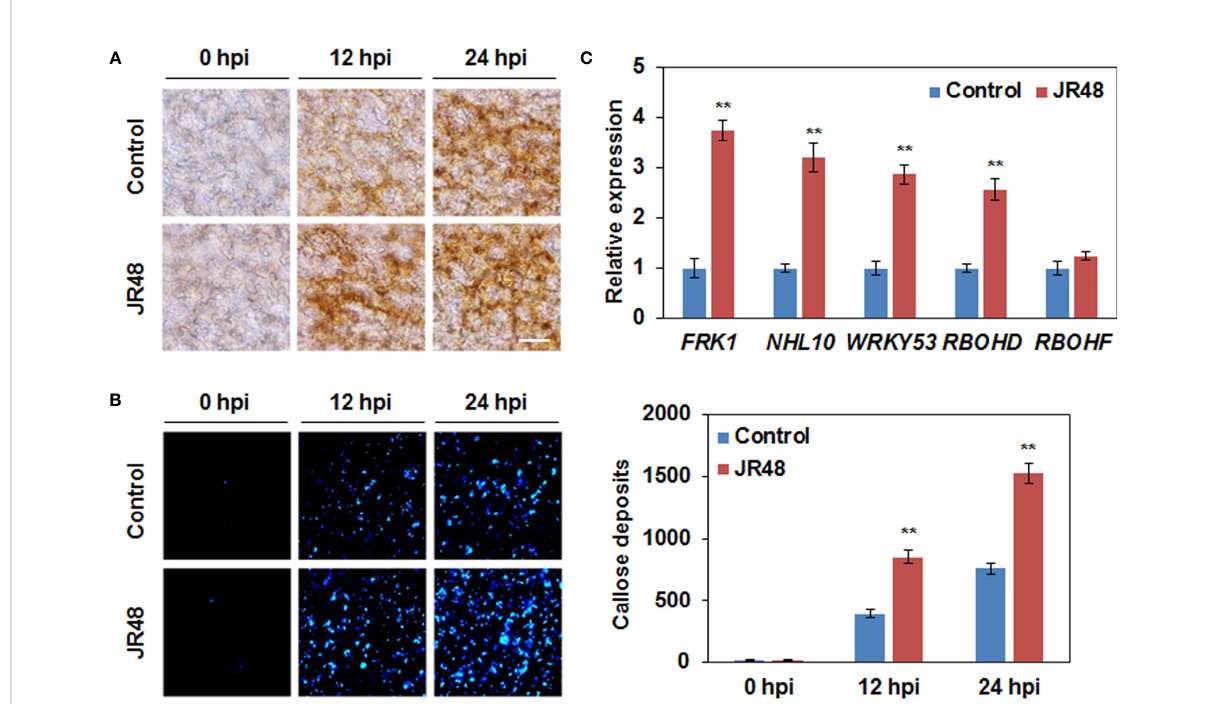
FIGURE 4 Enhanced plant defense responses and expression of defense-related genes by JR48. (A) H 2 O 2 accumulation during pathogen infection. Leaves of pre-treated wild-type Arabidopsis Col-0 were in fi ltrated with Xcc 8004. DAB staining was performed at the indicated time points. Scale bar, 60 m m. (B) Callose deposition during pathogen infection. Pre-treated Arabidopsis leaves were inoculated with Xcc 8004. Leaves were detached for callose staining at the indicated time points. Representative images were photographed and numbers of callose deposition were calculated (mean ± SD; n (number of leaves) ≥ 8). Student ’ s t -test was used to determine signi fi cant differences between Control and JR48 (**P < 0.01). Experiments were repeated in triplicate. (C) Relative transcript levels of PTI marker genes and two RBOHs . Relative expression of the indicated genes in Arabidopsis at 12 h post Xcc infection was determined by qRT-PCR. EF1 a was used as an internal reference. Each value represents the mean of three replicates and error bars indicate SD. Asterisks indicate signi fi cant differences (**P < 0.01, Student ’ s t -test). This experiment was repeated three times with similar